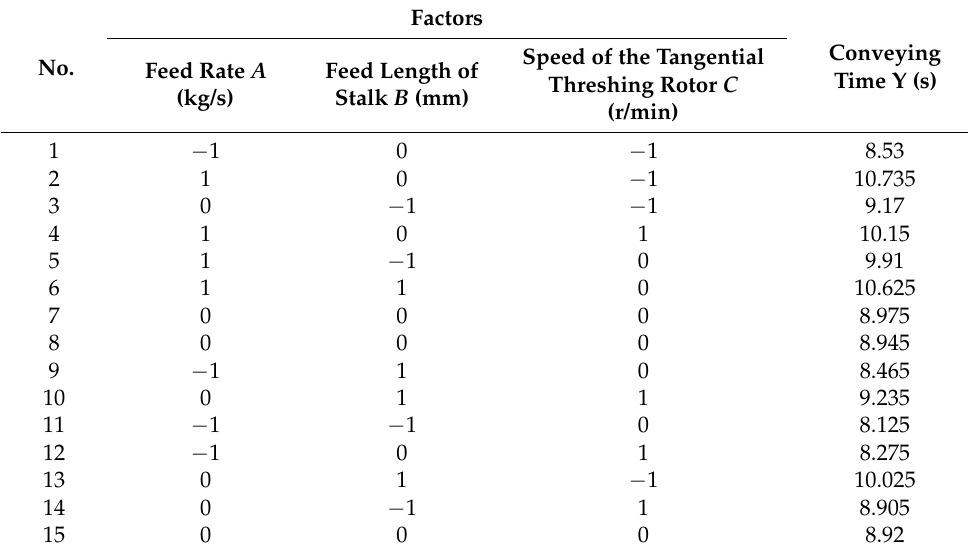
Table 4. Results of the conveying performance test.